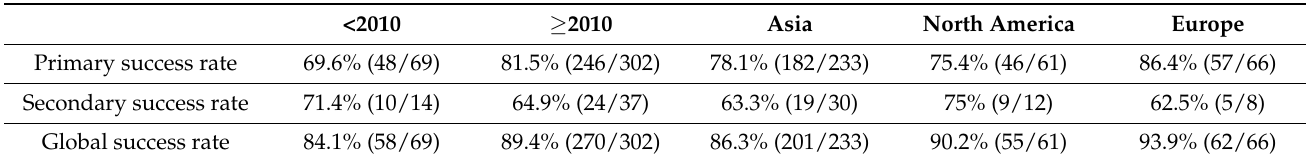
Table 5. Differences in primary, secondary, and global success rates prior to and after 2010 and across continents.